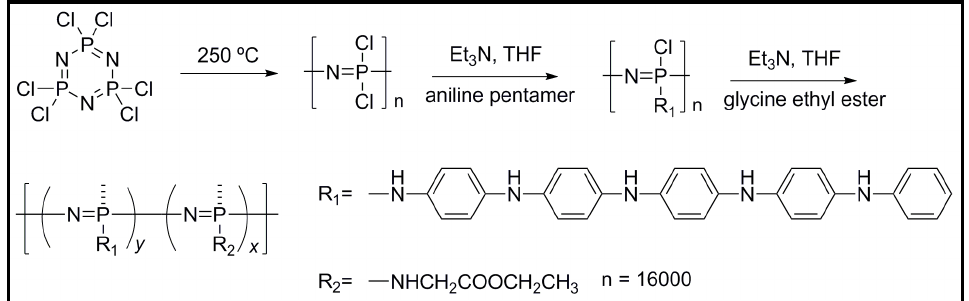
Figure 11. Structure and synthesis scheme for poly[(glycine ethyl ester) phosphacene]